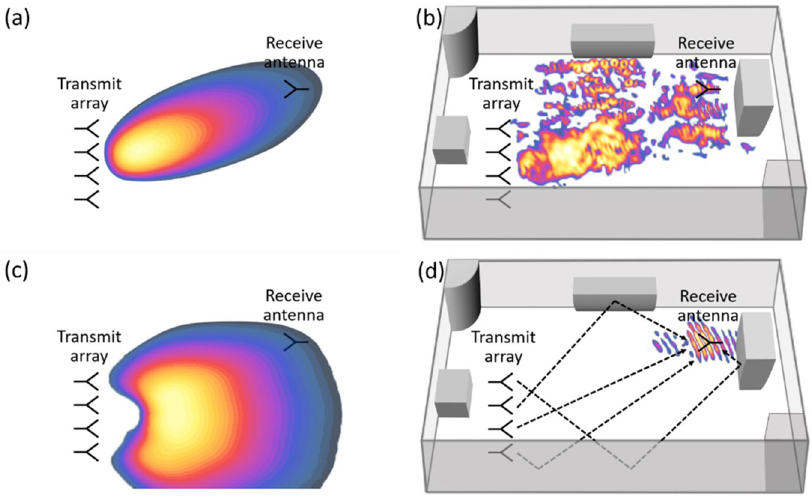
Figure 1. Illustration of array-based far-field wireless power transfer. ( a ) BF in free space. ( b ) BF in an indoor environment. ( c ) TR-based WPT in free space. ( d ) TR-based WPT in an indoor